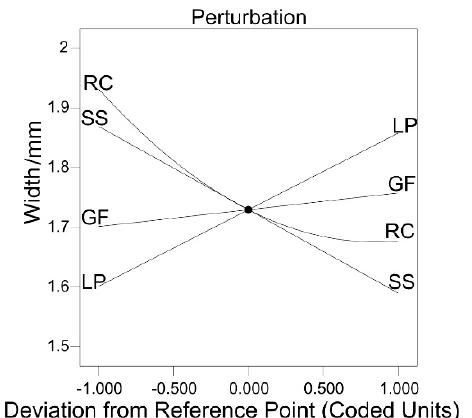
Figure 7. ( a ) 3D response surface showing the influence of scanning speed and gas flow on clad width. ( b ) Contour line of the response surface.